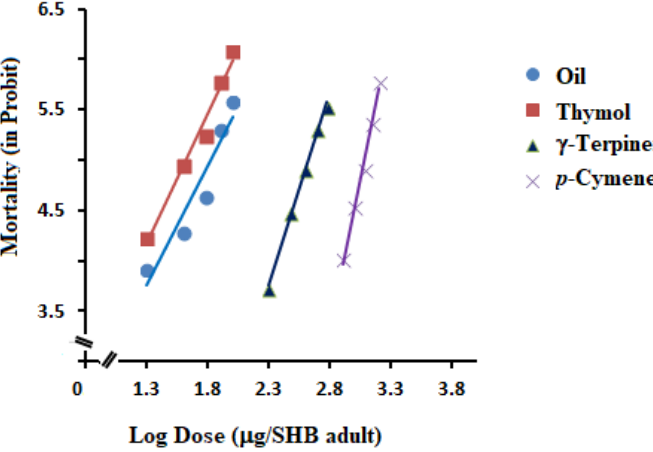
Figure 2. Dose-response lines of contact mortality of Trachyspermum ammi essential oil and its three main constituents (thymol, γ -terpinene, and p -cymene).